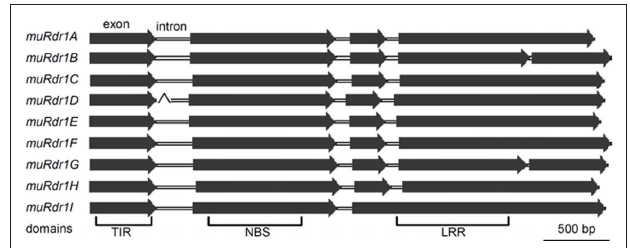
Figure 2 | The structure of the nine TNLs. The majority of the TNLs are characterized by four exons and three introns. The fourth TNL ( muRdr1D ) was interrupted by a 6957-bp transposable-element at intron 1.